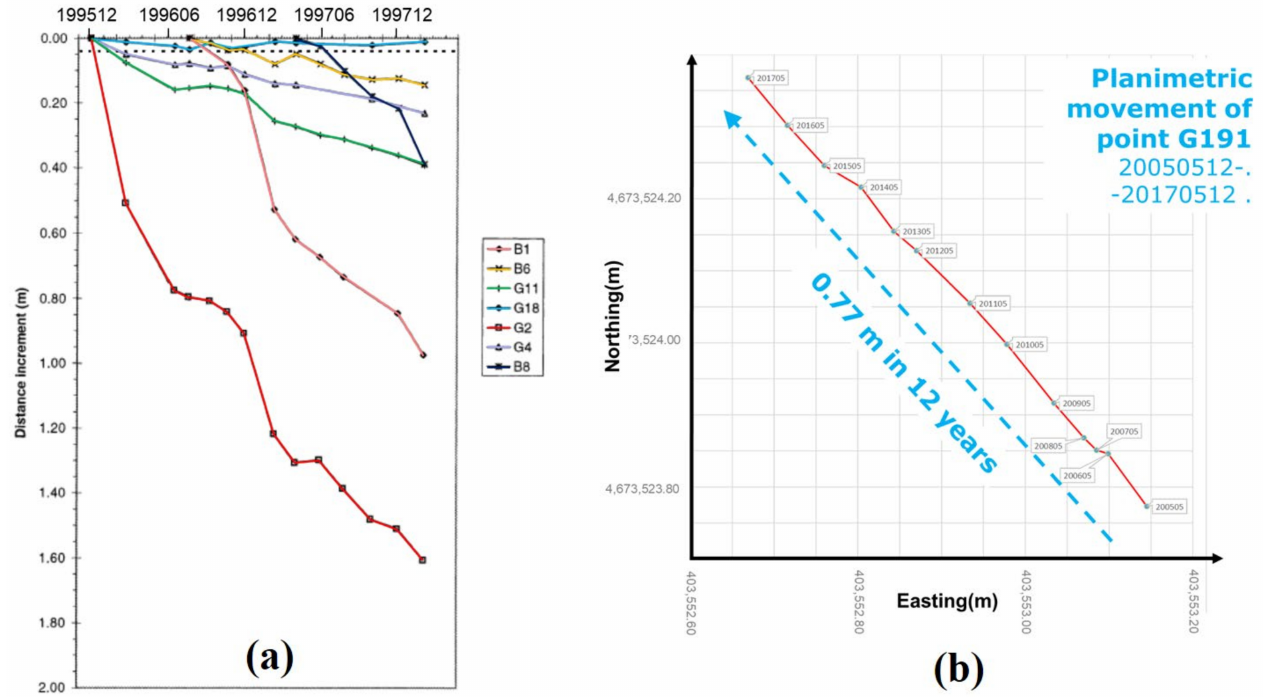
Figure 9. Examples of results of the GPS monitoring ( a ) planimetric displacements from the initial position in the period 1995–1998 ( b ) planimetric movement of one point during the yearly